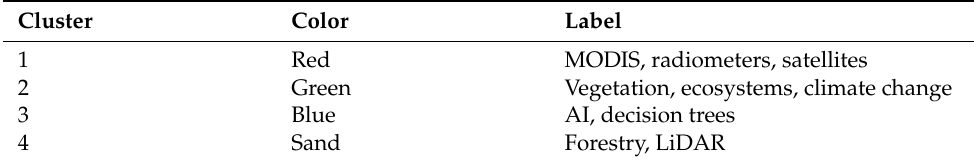
Table 1. Interpretation of co-occurrence clusters displayed in Figure 1. Cluster